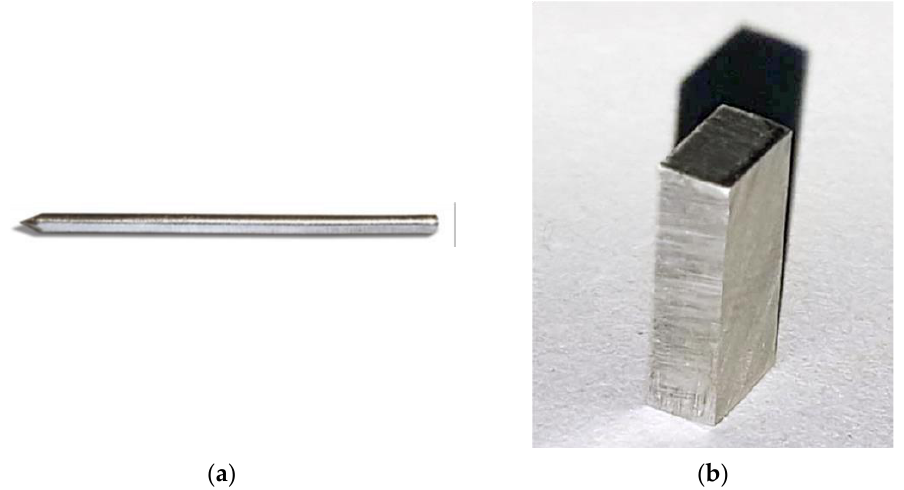
Figure 1. The aspect of Ma – 1Ca alloy implants used in the study: ( a ) 40 × 3.2 mm cylindrical implant of Mg – 1Ca alloy; ( b ) 1.2 × 1.2 × 0.2 cm parallelepiped implant.